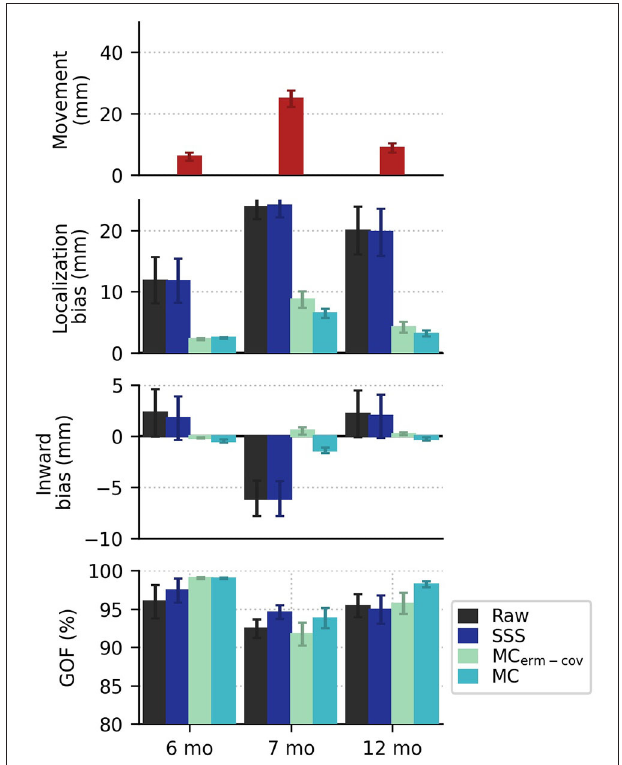
FIGURE 2 | In the top row, the mean plus or minus standard error (across subjects) of the position deviation (from each subject’s mean head position) shows smaller movements in the more recent recording (published in 2021) compared to an older recording (published in 2014). In the second row, localization bias is reduced by movement compensation, with greater reduction in bias when the covariance is computed from movement-compensated data. There are systematic outward and inward (relative to the head center) localization biases shown for the newer (2021) and older (2014) data, respectively. In the last row, mean goodness of fit values exceed 80% in all